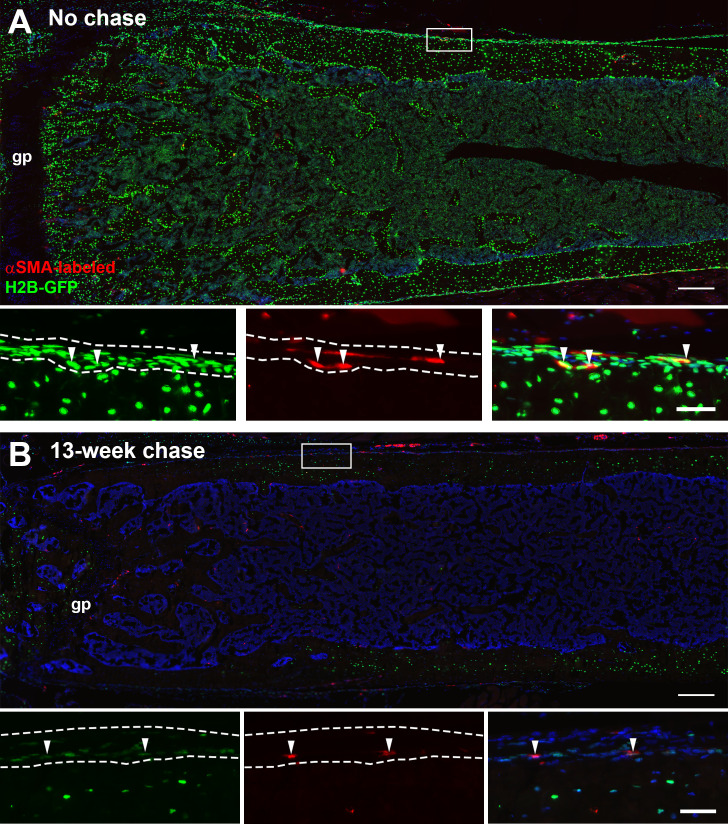
Histology of H2B-GFP/αSMACreER/Ai9 femurs.(A) H2B-GFP expression in a distal femur following 5-week doxycycline (dox) and 2 days after tamoxifen. (B) H2B-GFP label-retaining cells after 13-week chase; tamoxifen was given at the time of dox withdrawal. Boxed areas are magnified. Dashed lines indicate the periosteum and arrowheads indicate GFP+ αSMA-Tom+ cells in the cambium layer of the periosteum. gp, growth plate. Scale bars are 250 or 100 µm (high magnification images).